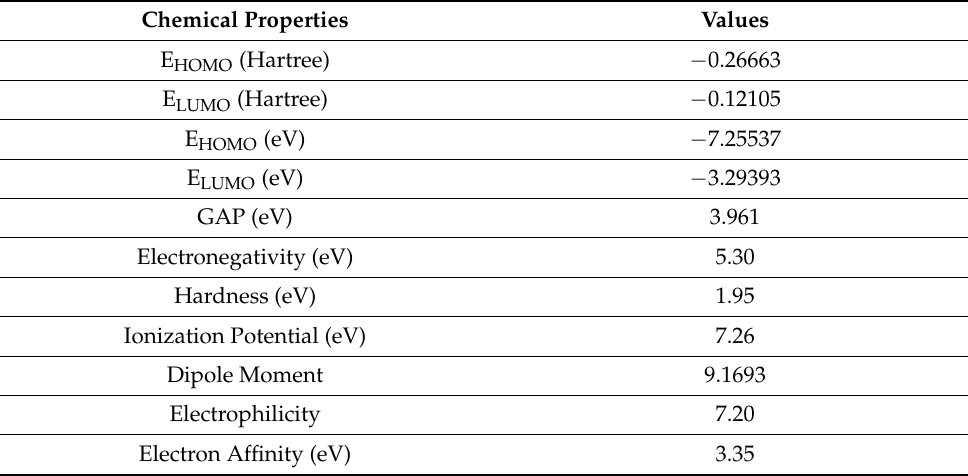
Figure 13. The highest occupied molecular orbital (HOMO) for the protonated α -linoleic acid in the aqueous phase.